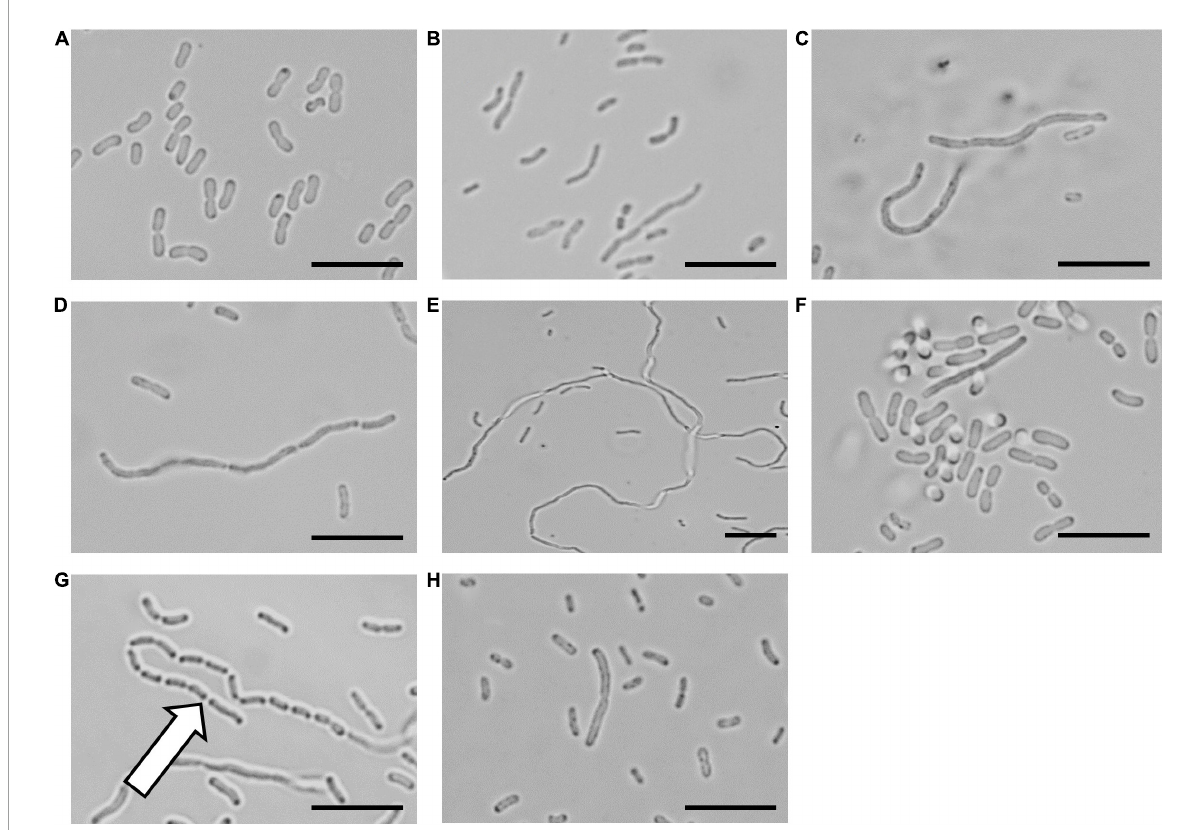
FIGURE2 The LXC compounds inhibit cell division in Acinetobacter baumannii ATCC 19606 A. baumannii ATCC 19606 culture was adjusted to a density of approximately 2.7 × 10 8 CFU/mL in MH broth and incubated at 37 ◦ C with the LXC compounds. A 1 µ L aliquot was taken out at varying timepoints (0, 1, 3, 6, and 18 h) and imaged by light microscopy. The images for 6 h are depicted here. Images are (A) in the absence of the compounds, (B) with the divisome inhibitor, divin at 64 µ g/mL, or with the LXC compounds at 2 × MIC values: (C) compound 1 at 256 µ g/mL, (D) compound 2 at 256 µ g/mL, (E) compound 3 at 256 µ g/mL, (F) compound 4 at 64 µ g/mL, (G) compound 5 at 512 µ g/mL and (H) compound 6 at 128 µ g/mL. The white arrow indicates “grooving” site, an indication of where separation of daughter cells should take place. Scale bar is 50 µ